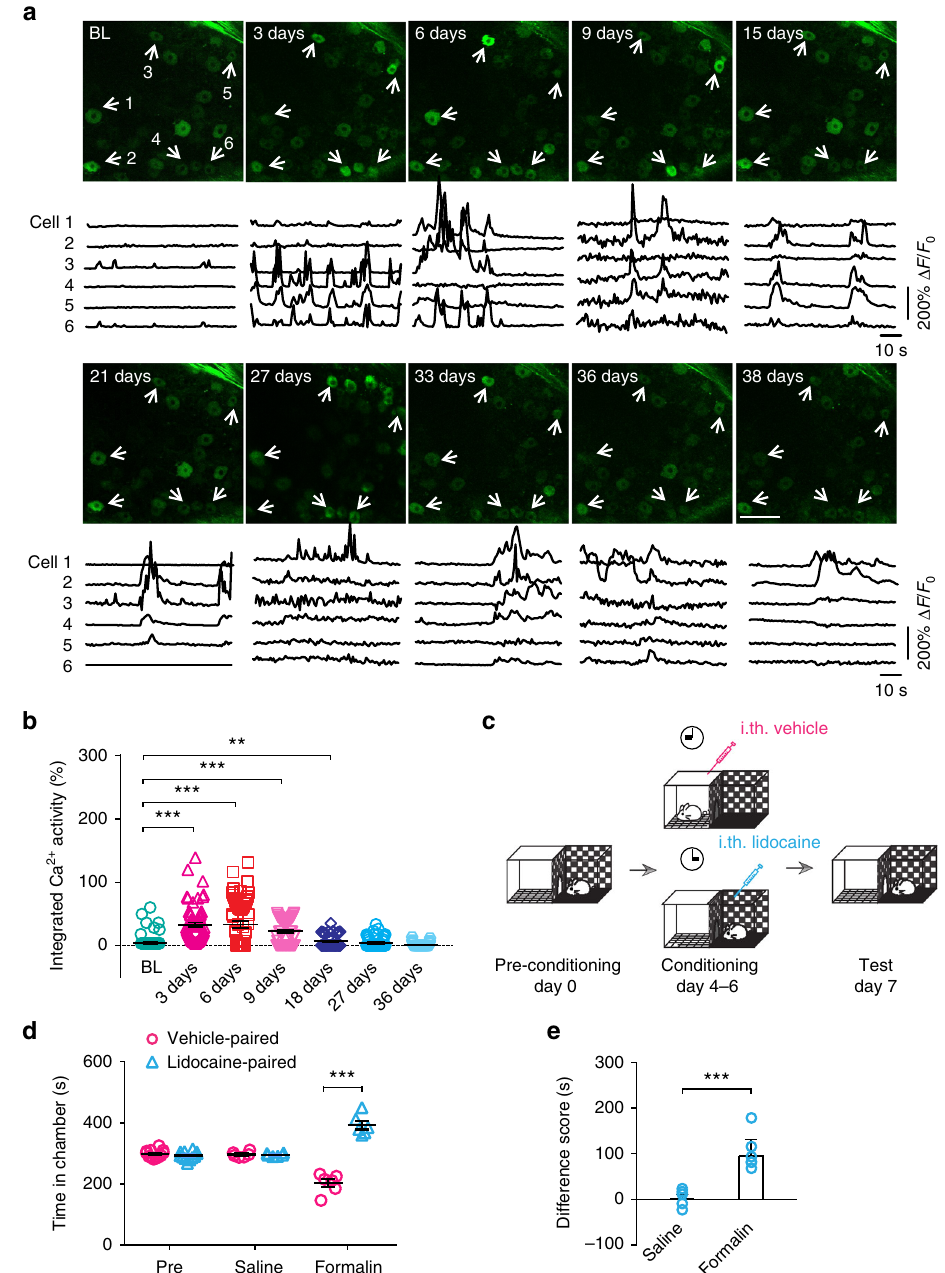
Fig. 6 Plantar formalin injection induces long-lasting elevation of neuronal Ca 2 + activity. a Representative two-photon images and fl uorescence traces of DRG sensory neurons expressing GCaMP6s, before and after formalin injection. Scale bar, 100 μ m. b Integrated Ca 2 + activity of DRG neurons over